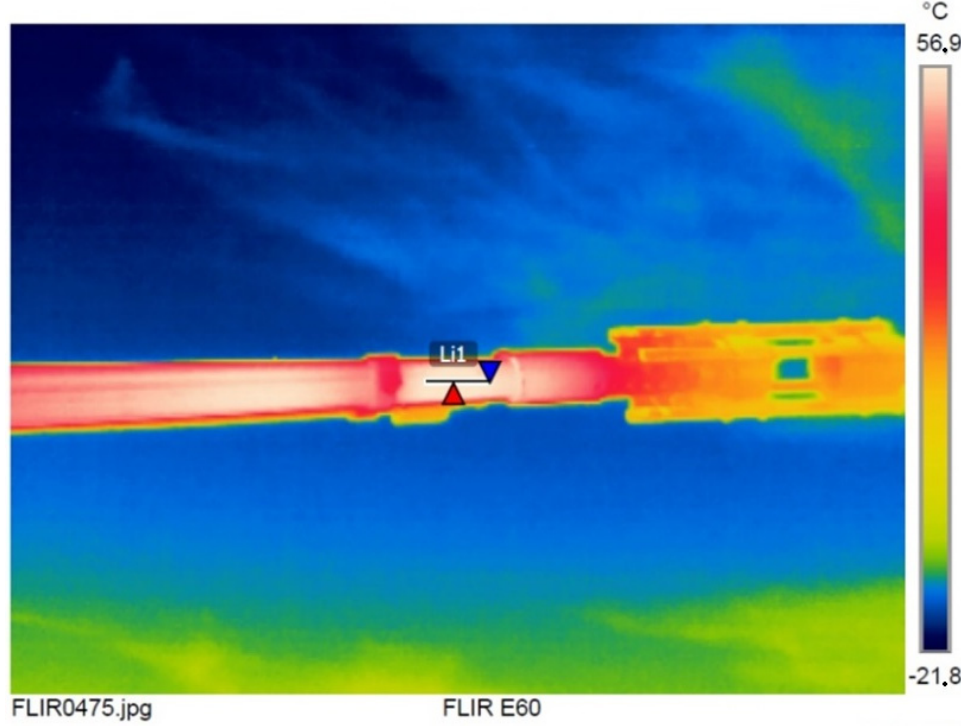
Figure 7. Temperature distribution of the barrel external surface in the near-muzzle region. Table 4. Results of temperature measurements.